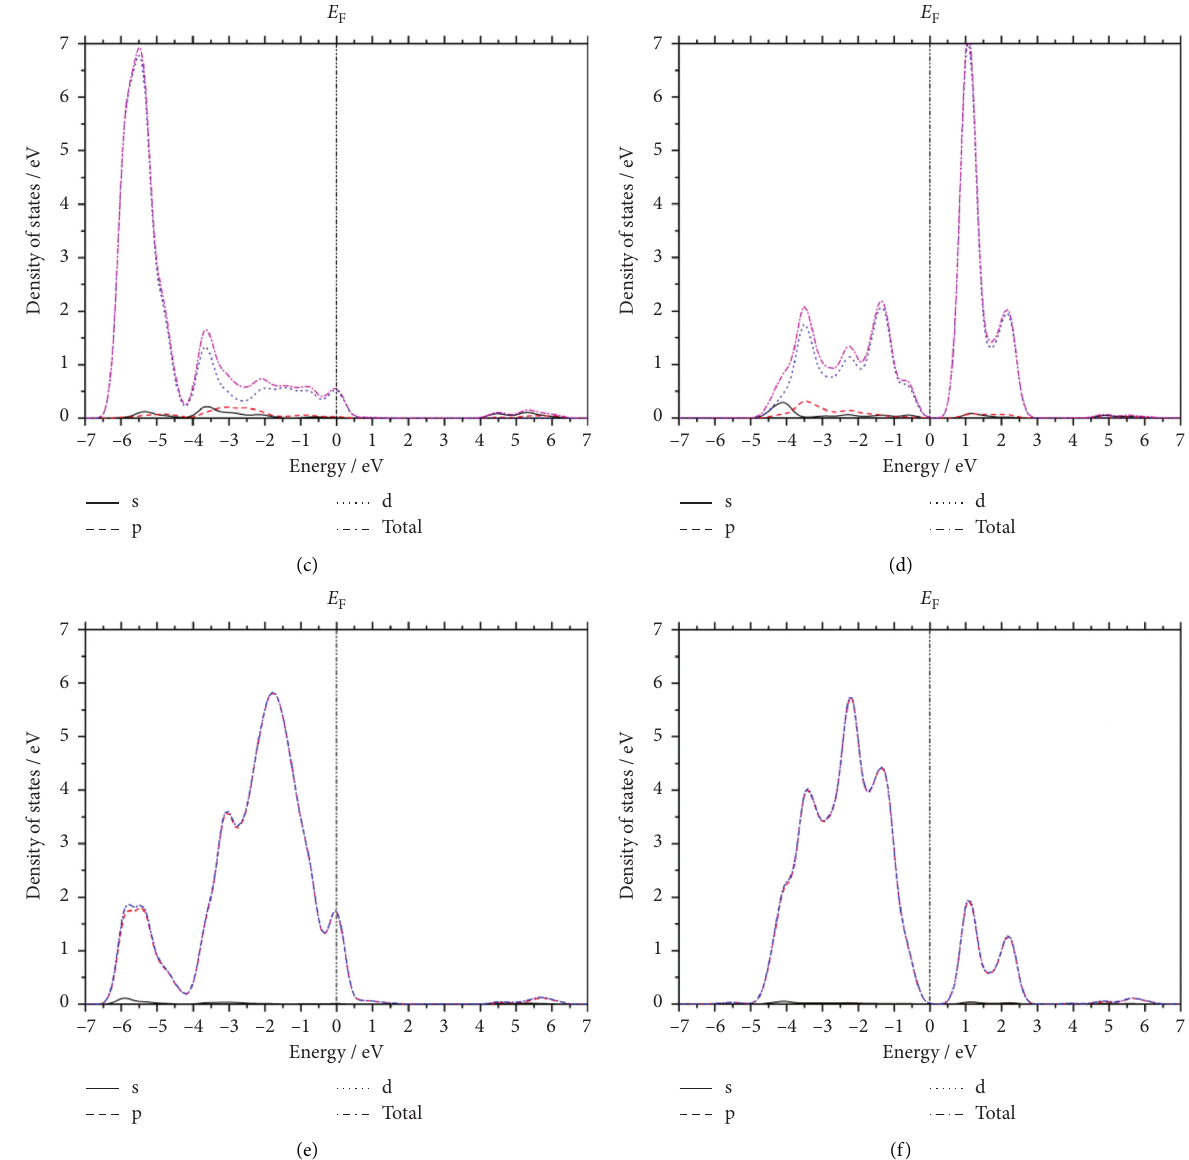
Figure 10: Detailed electron density of states of Ca (a for spin-up and b for spin-down), Co (c for spin-up and d for spin-down), and O (e for spin-up and f for spin-down) for CaCoO layer within sandwiched Ca 2 Co 2 O 5 crystalline